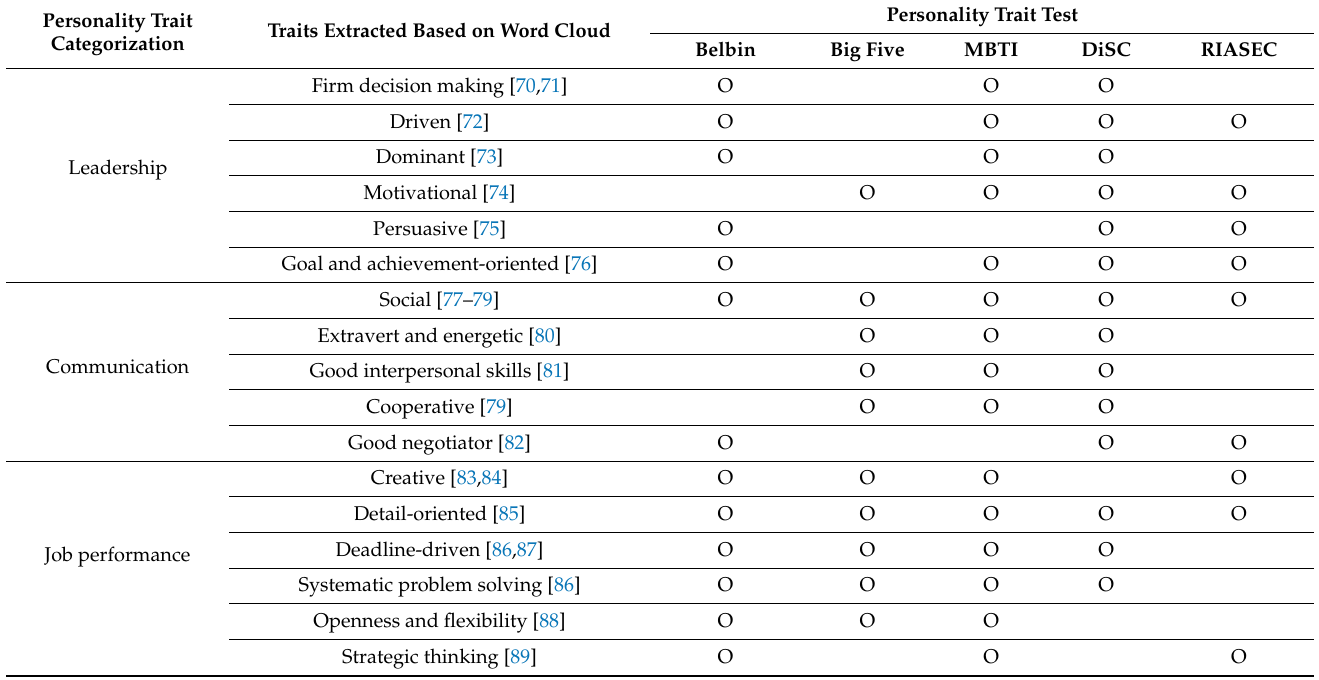
Table 1. Personality traits extraction and